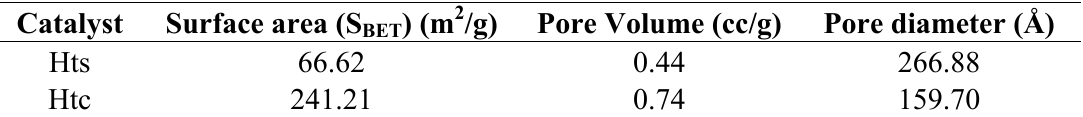
Table 1. Hydrotalcites’ textural